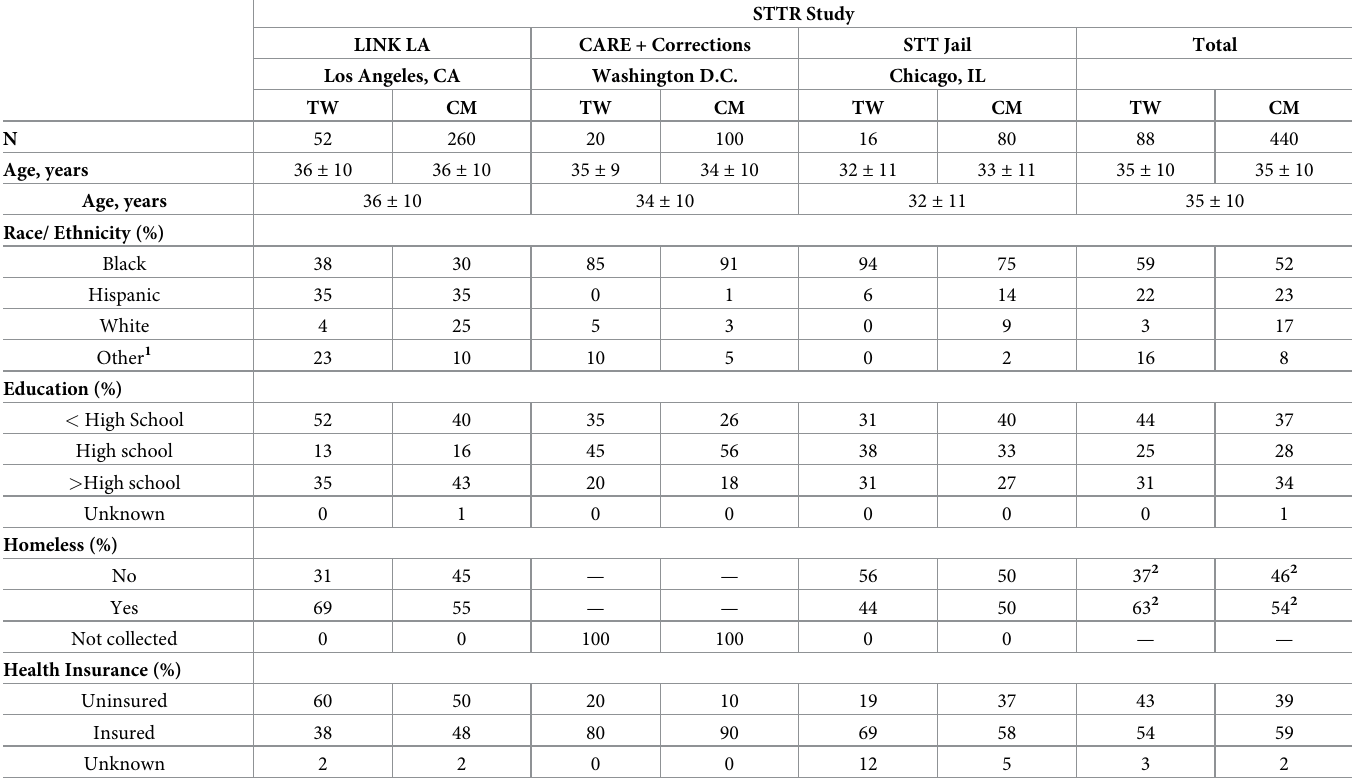
Table 2. Demographic characteristics of study participants, comparing transgender women and cisgender